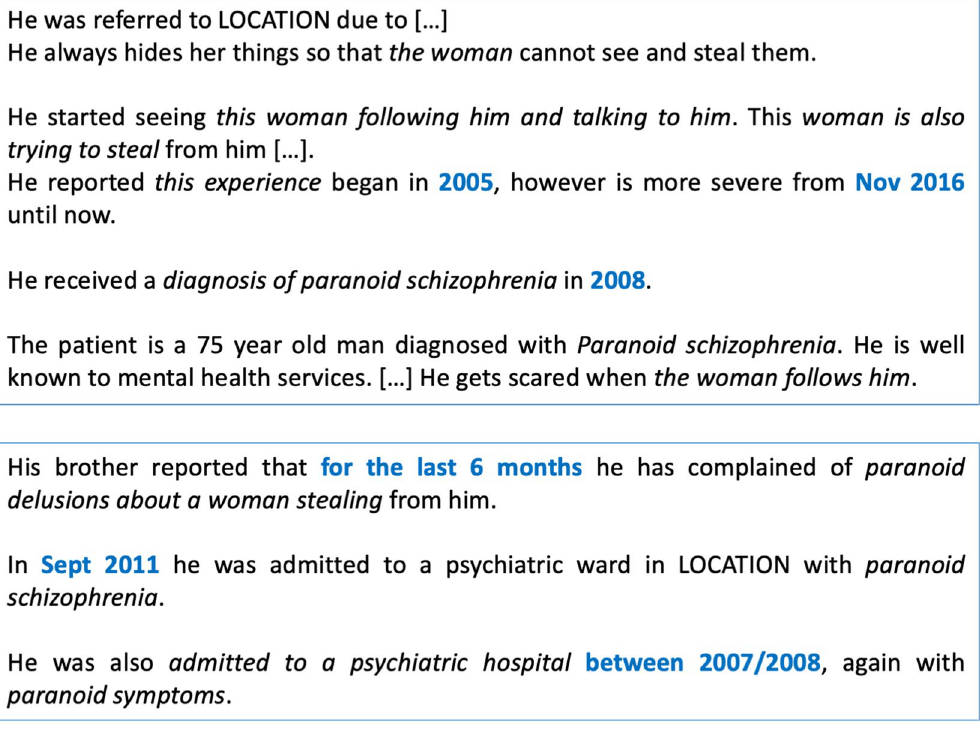
Figure 1. Example of a fictive patient’s EHR documentation including clear psychosis onset information as well as current symptomatology and past diagnoses. Potentially relevant clinical information is marked in italics, while temporal information is marked in